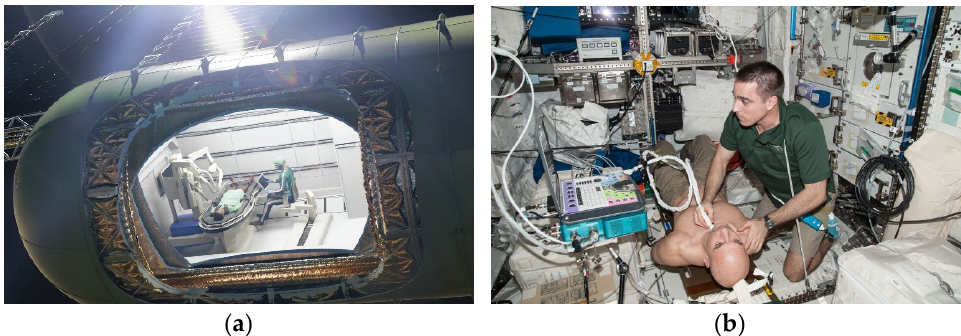
Figure 2. ( a ) Virtually rendered cutaway view of a postulated trauma pod surgical module with a four-armed surgical robot in the module. The patient is tethered to the operating table, while the assistant, using a touchscreen console, is tethered to the module structure via a movable chair. Illustration by T. Trapp (CC BY-SA 4.0). [6] ( b ) In the International Space Station’s Columbus laboratory, NASA astronaut Chris Cassidy performs an ultrasound on ESA astronaut Luca Parmitano for the naut height increases while advancing medical imaging technology, by testing a smaller and more- portable ultrasound device aboard the station. Photo taken from [7] in compliance with NASA’s image use policy [8].